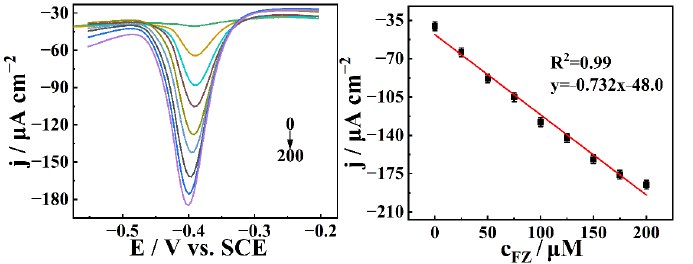
Figure 7. ( A ) DPV of CuNPs/CN/GCE in 0.2 M N 2 -statured PBS (pH = 7) to detect FZ. ( B ) Plot of peak current density and concentration.